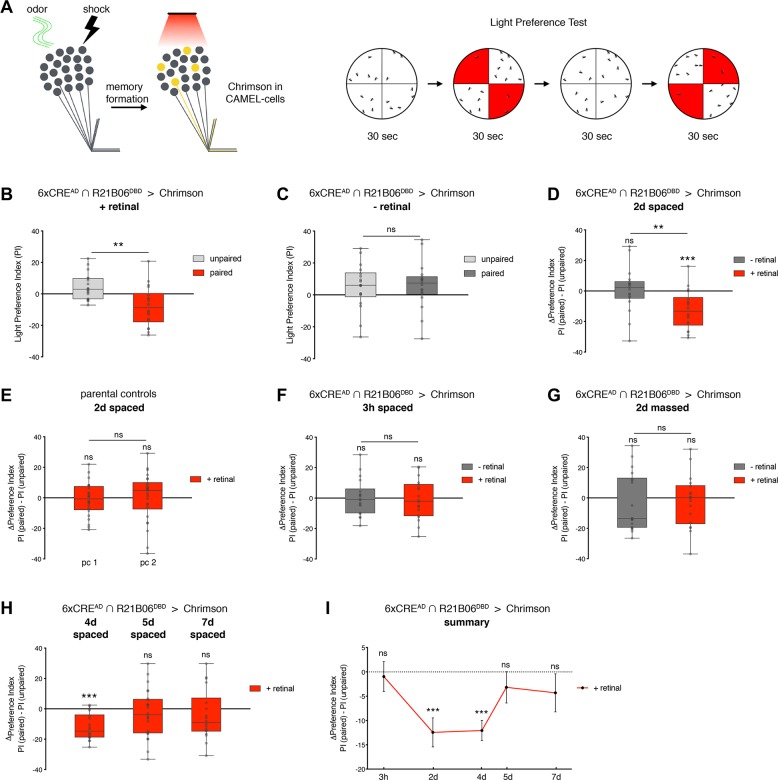
Artificial reactivation of CAMEL neurons elicits aversive behavior.(A) Schematic drawing of the experimental setup and the light preference test. (B) Two days after spaced training, paired conditioned flies significantly avoid red light quadrants compared to unpaired controls. (C) This aversive behavior depends on feeding of the essential Chrimson co-factor retinal. (D) The difference between PIs of paired and unpaired groups (ΔPI, from panels B–C) represents total light avoidance (−12.44 ± 2.99 for retinal-fed flies 2 days after training) and is significantly different from 0 and significantly different between retinal- and non–retinal-fed cohorts. (E) ΔPIs of parental control genotypes that were subjected to identical training and testing protocols including retinal feeding were not significantly different from 0 (pc 1: UASChrimson/+; 6xCREAD/+ and pc 2: R21B06DBD/+). (F–G) No change in light avoidance between paired and unpaired trained groups was observed 3 hours after spaced training (panel F) or 2 days after massed training in the presence or absence of retinal (panel G). (H) Four days after spaced training, the experimental group showed a ΔPI that significantly differs from 0 (−12.06 ± 2.06 for retinal-fed flies 4 days after training). No significant change in light preference was observed 5 days or 7 days after training. (I) Summary of the data. For box plots: line, median; box, 75th–25th percentiles; whiskers, minimum to maximum (n ≥ 18). Data in panel I represent mean ± SEM. Asterisks indicate significant differences between relevant groups or 0 (**P < 0.01, ***P < 0.001, unpaired and one-sample t test). CAMEL, CRE-activity–dependent memory engram label; CRE, cAMP response element; ns, not significant; pc, parental control; PI, Preference Index; SEM, standard error of the mean; UAS, upstream activation sequence.